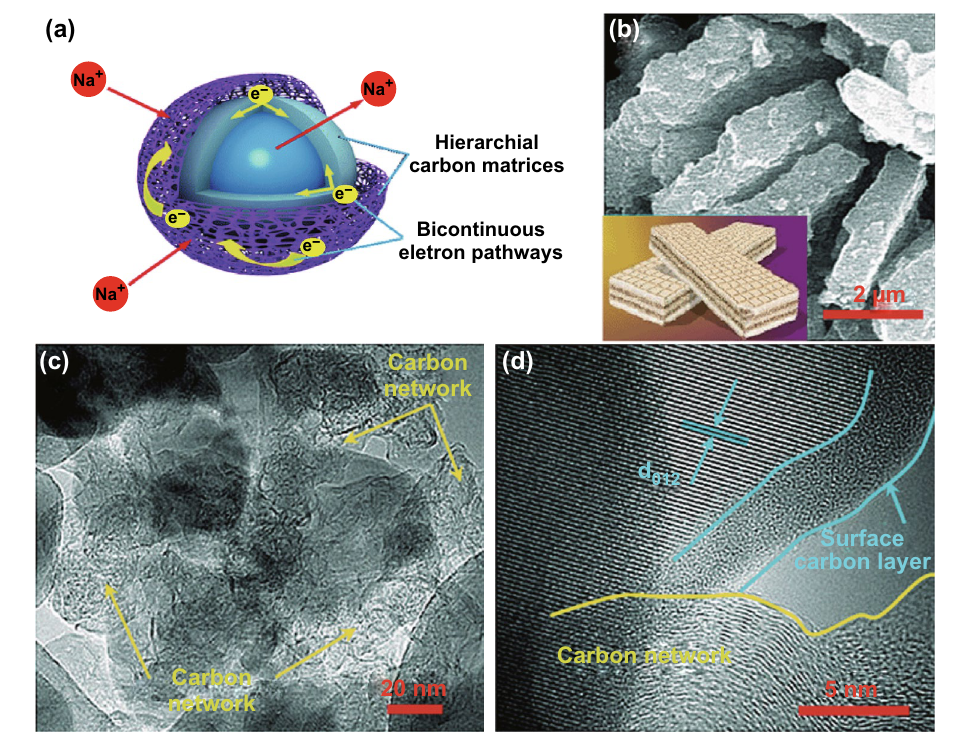
Fig. 9 a Schematic image of enlarged parts in the wafer-like architecture with bicontinuous pathways for high-efficiency electron/ion transport. b SEM images of the wafer-like particles. c TEM image of the wafer-like particle. d HRTEM image of one primary particle decorated by hierar- chical carbon [155]. Copyright 2015, the Royal Society of